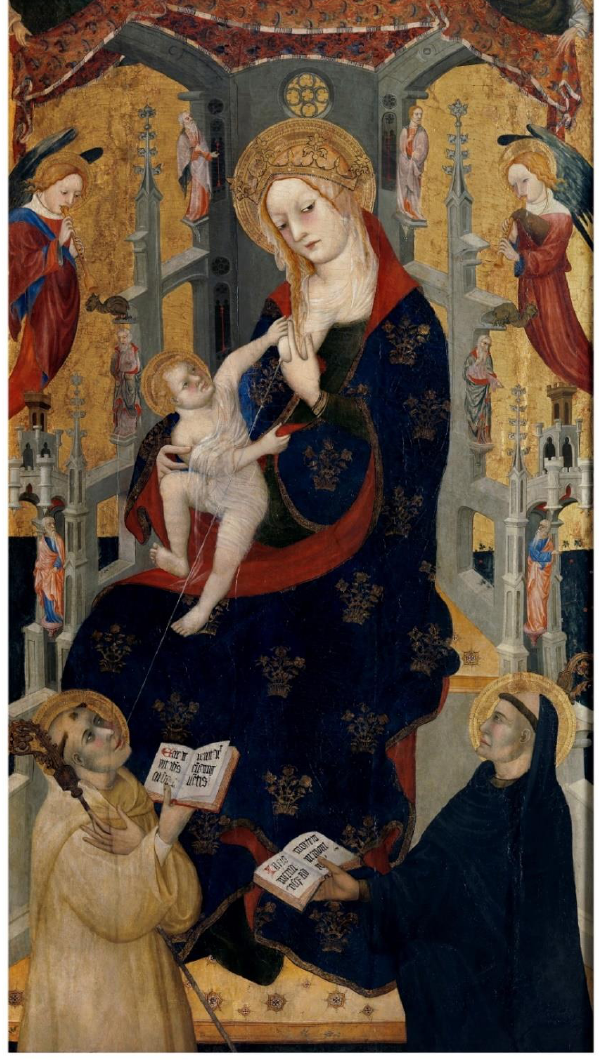
Figure 3. Pere Lembrí. The Virgin nursing the Child between Saints Bernard of Clairvaux and Benedict . Virgen del Tobed, Museo del Prado. ©Museo Nacional del Prado